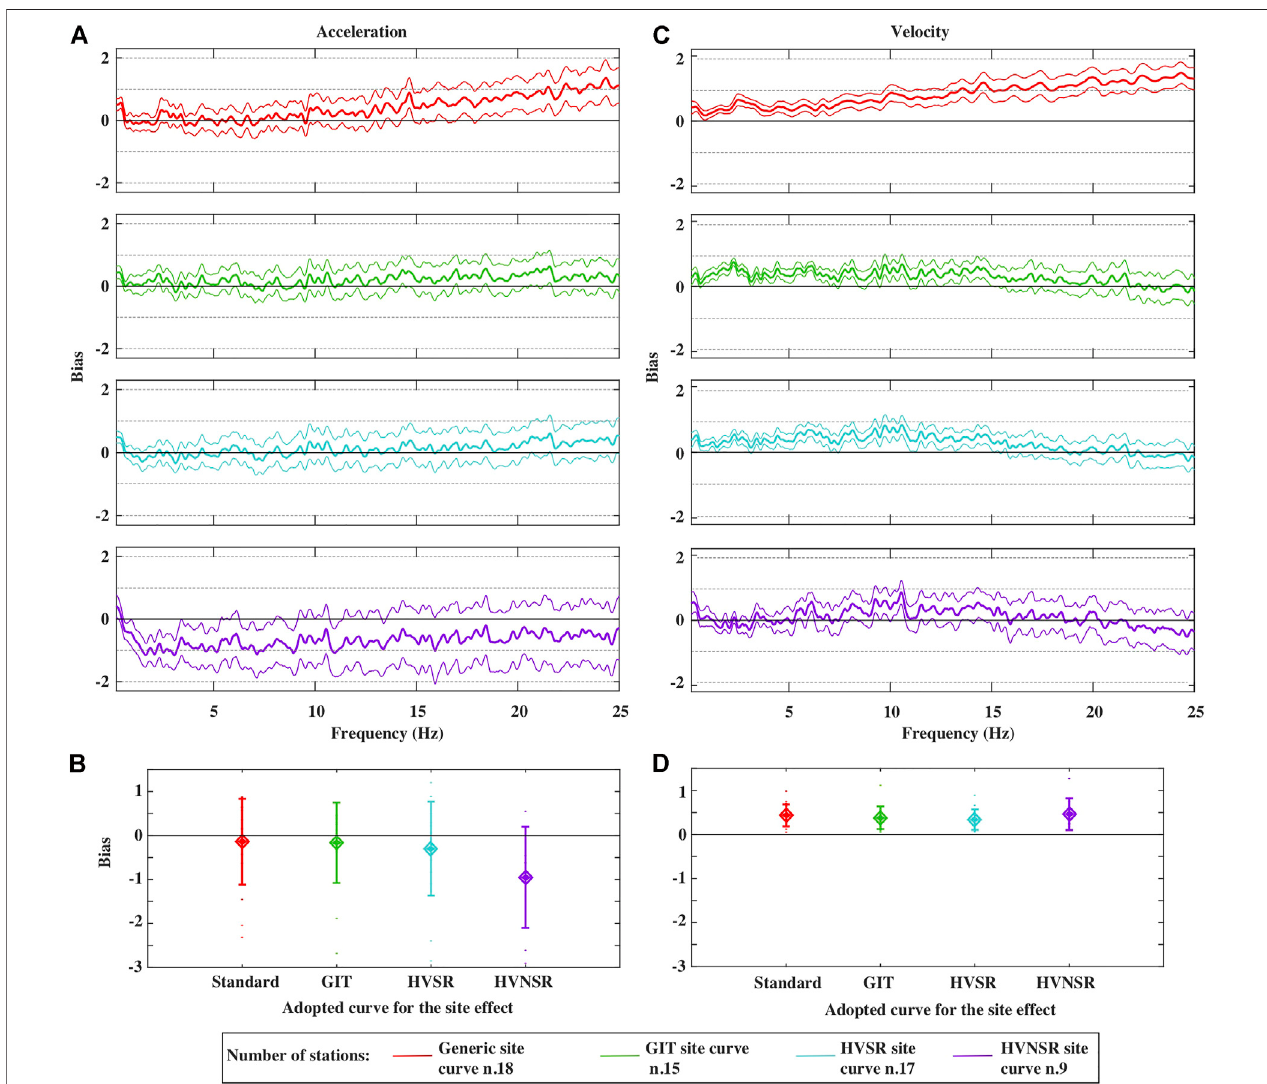
FIGURE 7 | Bias calculated following Eq. 10 , to get an insight into the performance of the generic and empirical site ampli fi cation curves exploited in the EXSIM codealloverthestationsampleontopography.Thetoppanelsshowbiasversusfrequencyforbothacceleration (A) andvelocity (C) spectra.Blackcurvesrepresentthe bias obtained by applying the generic site curve, while color curves are related to the use of GIT (green), HVSR (cyan), and HVNSR (violet) site curves. The standard deviation is plotted as well. The bottom panels show the bias calculated for peak ground acceleration [PGA, panel (B) ] and peak ground velocity [PGV, panel (D) ].